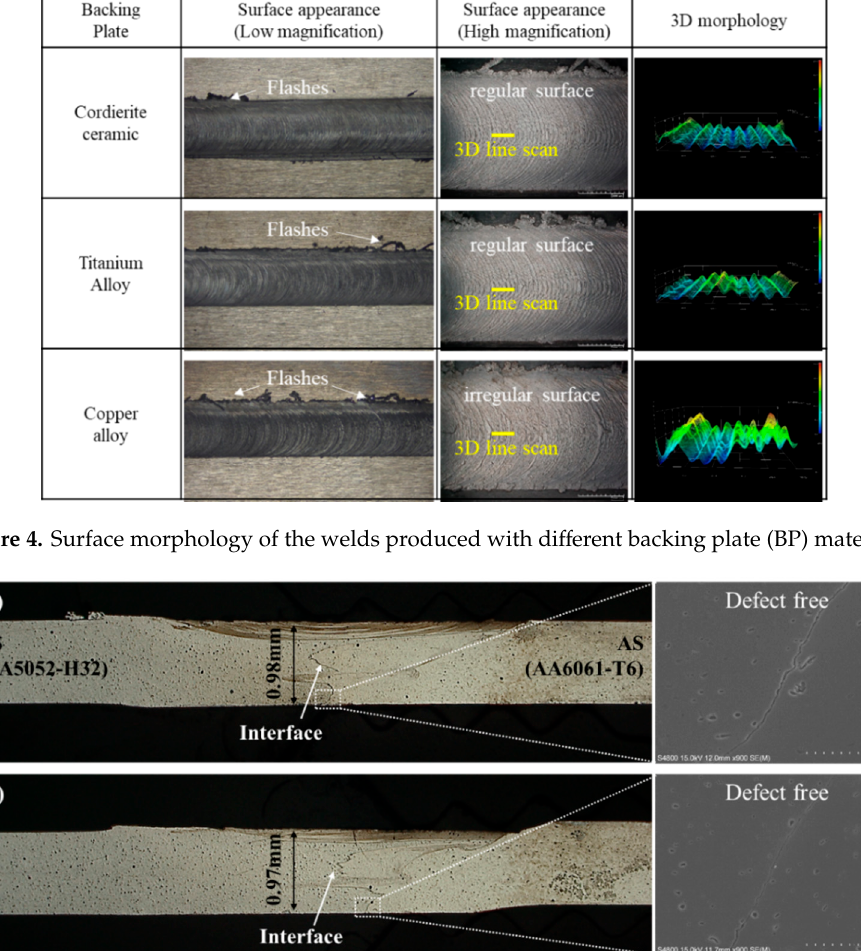
Figure 4. Surface morphology of the welds produced with different backing plate (BP) materials.